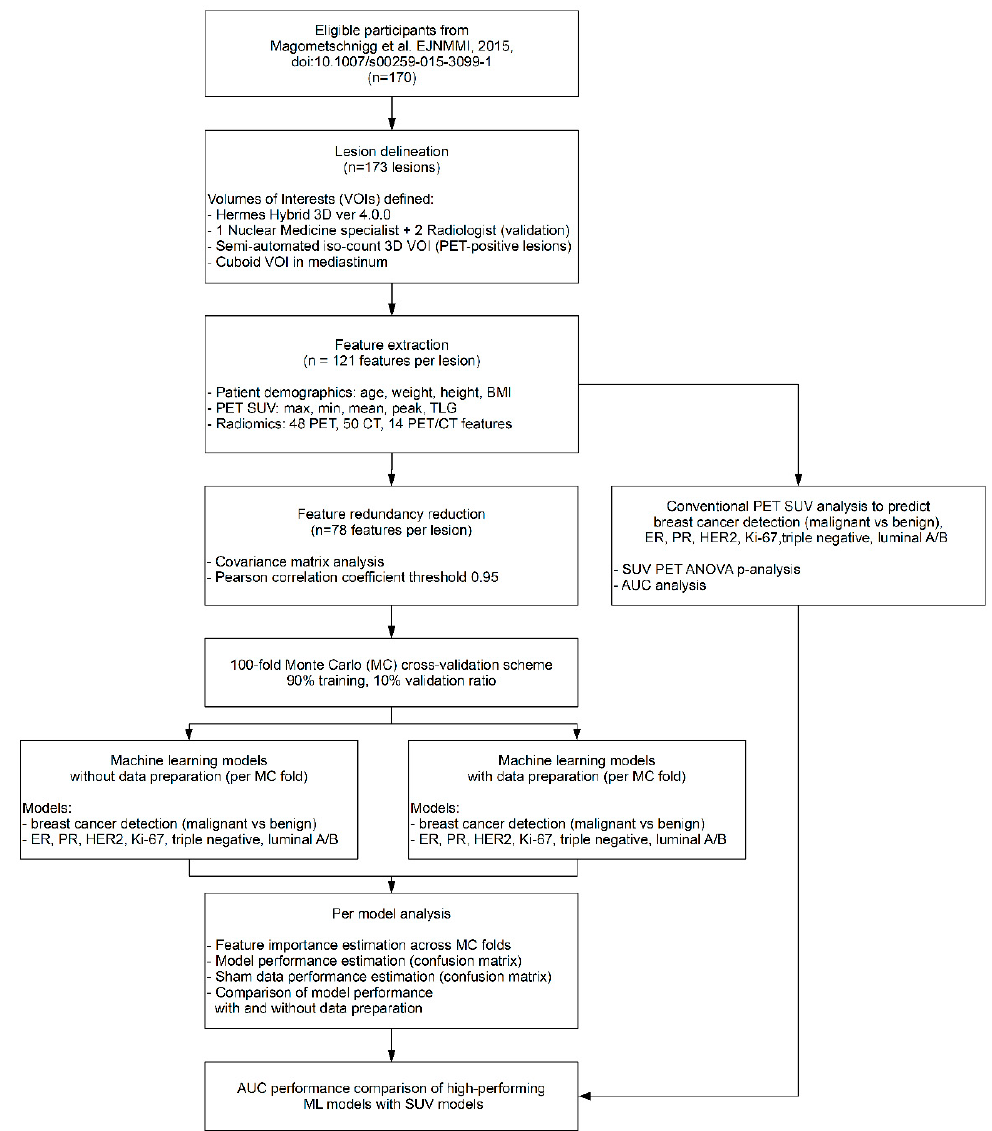
Figure 1. The analysis workflow of the collected dataset. Prospective study conducted between 2009 and 2014, approved by the institutional review board provided data records for 170 patients. [ 18 F]FDG-PET/CT of the breast was performed with a dedicated breast imaging protocol using a combined whole-body PET/CT system. 173 lesions were delineated and extracted following the imaging biomarker standardization initiative (IBSI) guidelines combined with optimized feature extraction principles. Feature redundancy reduction was performed resulting in 77 features. Monte Carlo cross validation was utilized to generate 100 training vs. validation folds. Pre-processing steps were performed over training data. Ensem- ble learning scheme was utilized to establish predictive models. All machine learning models underwent confusion matrix analytics, sham data analysis, and Area Under the Receiver Operator Characteristics Curve (AUC) analysis across MC folds and the conventional PET SUV analysis. VOI = Volume of Interest; BMI = Body Mass Index; ER = Estrogen; PR = Progesterone; HER2 = Human Epidermal Growth Receptor 2; PET–Positron Emission Tomography; CT–Computed To- mography.